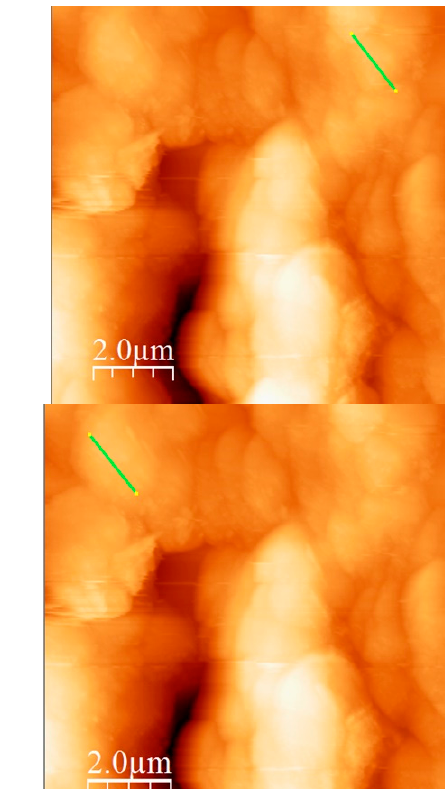
Figure 6. 2D and 3D images obtained for BCp/BC sample.